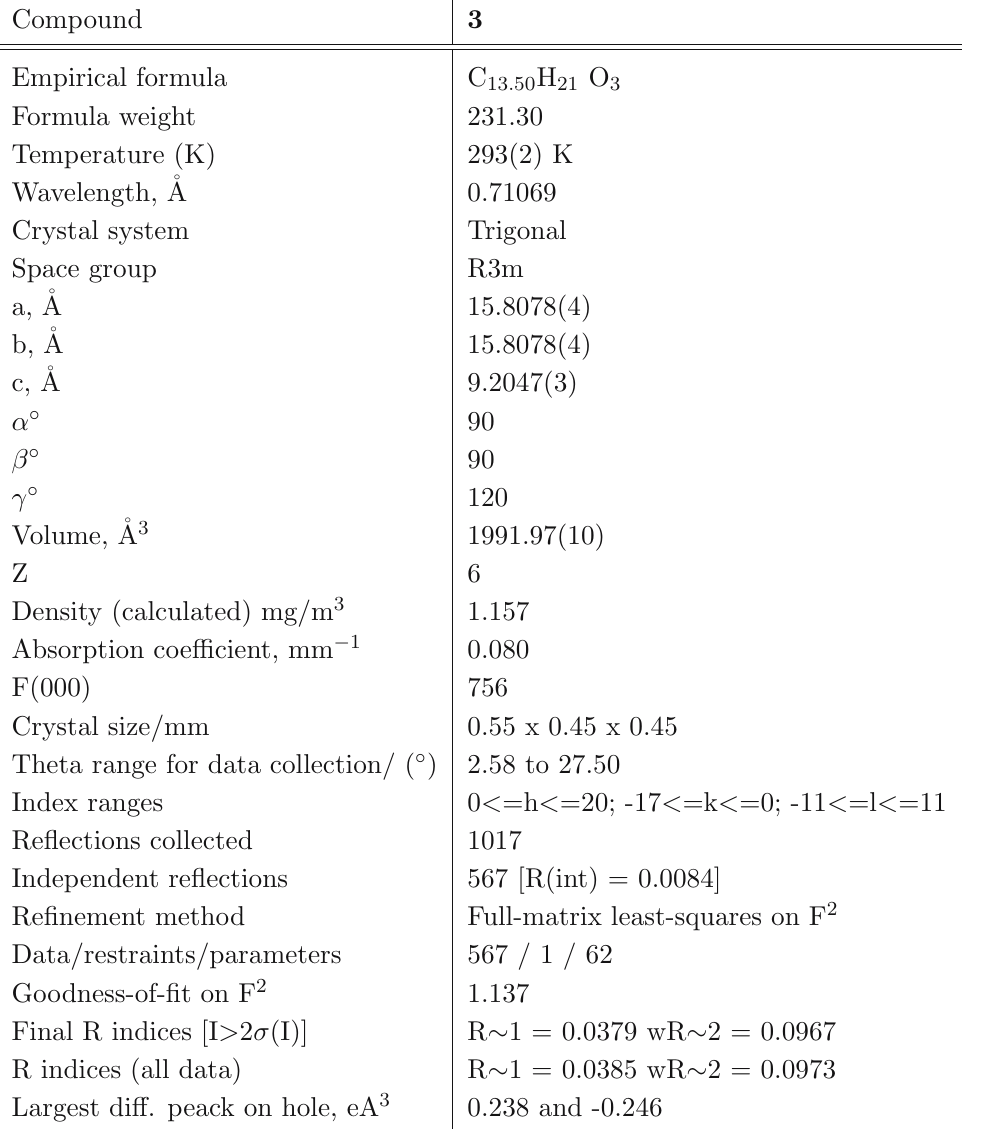
Table 2 Parameters of the crystalographic determination for 3